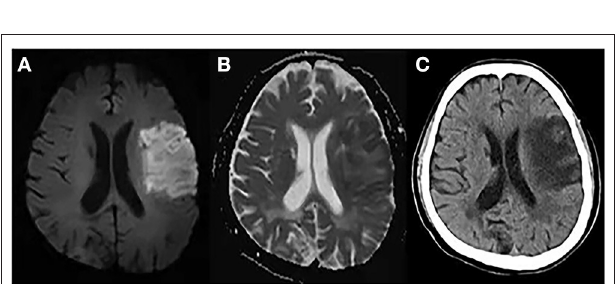
FIGURE 5 | Cytotoxic edema, ionic edema, and vasogenic edema on MRI and CT. A 69-year-old male underwent MRI and CT on day 5 post-stroke. (A) DWI shows hyperintensity in the left frontal and parietal lobes. (B) ADC map shows hypointensity in the marginal area of the lesion, indicating cytotoxic edema, and hyperintensity in the lesion center, indicating ionic and vasogenic edema. (C) CT image shows hypodensity in the left frontal and parietal lobes, especially in the area of ionic and vasogenic edema (i.e., ADC hyperintensity